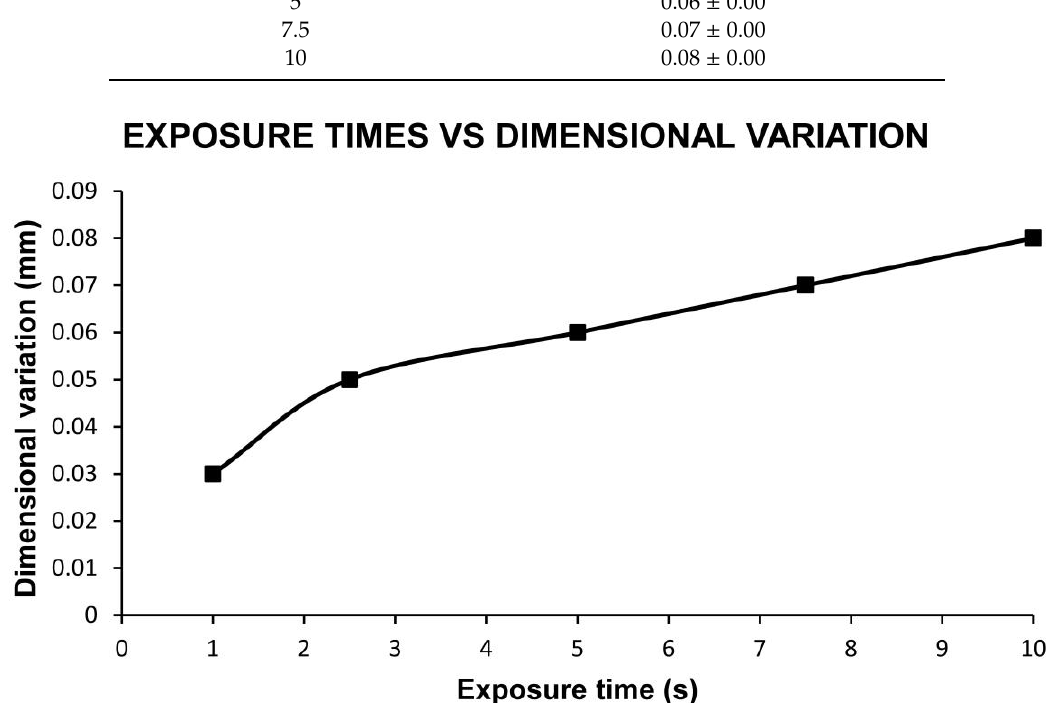
Figure 1. Dimensional variation for each exposure time and layer height of 0.06 mm.